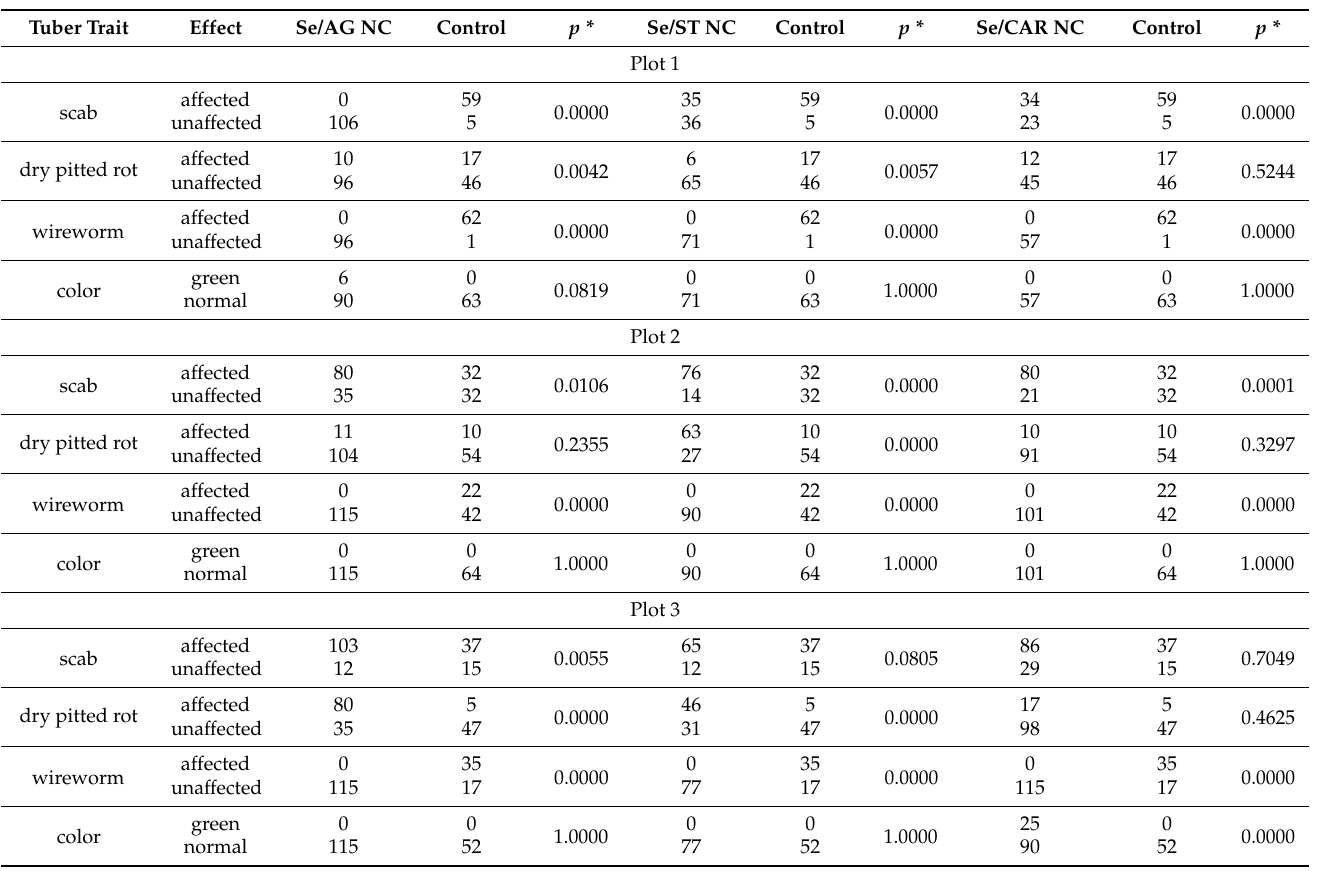
Table 4. Number of tubers in the visual analysis of healthy traits in the first generation tubers obtained from plants grown from tubers treated with selenium (Se) nanocomposites (NCs) after 230 days of